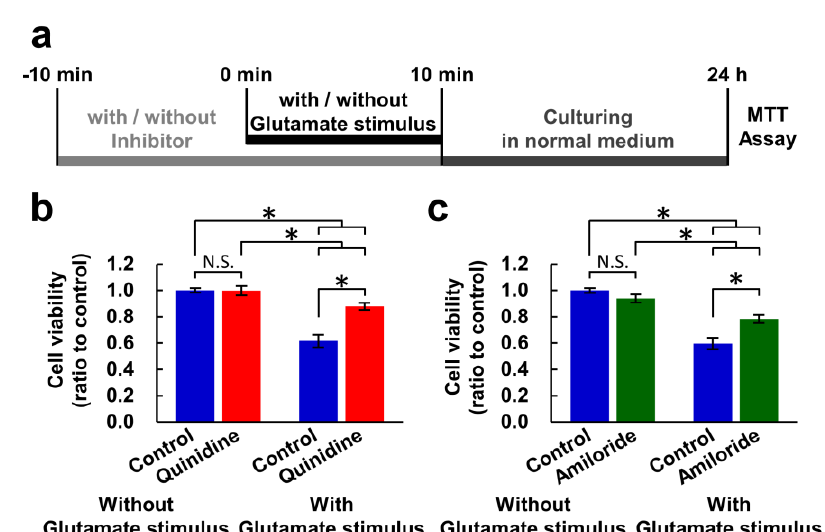
Figure 1. Inhibitors of Mg 2+ extrusion attenuated excitotoxicity. ( a ) Experimental procedure of the MTT assay for measuring the effect of a ten-minute glutamate stimulus. Comparison of cell viability in the presence or absence of quinidine (200 μM) ( b ) or amiloride (500 μM) ( c ) ( n = 30 for each). Error bars indicate SEM. * indicates P < 0.05 among all possible combinations by Tukey’s test. N.S. indicates no statistically significant difference.